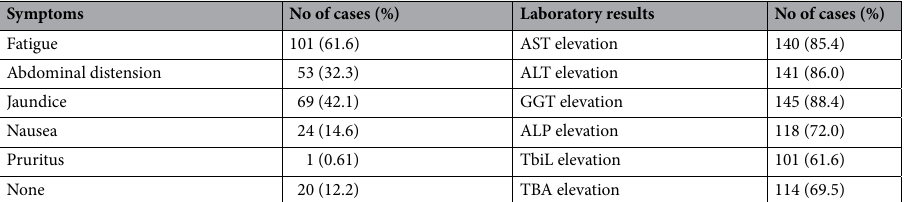
Table 2. Clinical characteristics of 164 patients with drug-induced liver injury. AST aspartate aminotransferase, ALT alanine aminotransferase, GGT gamma-glutamyl transferase, ALP alkaline phosphatase, TbiL total bilirubin, TBA alkaline